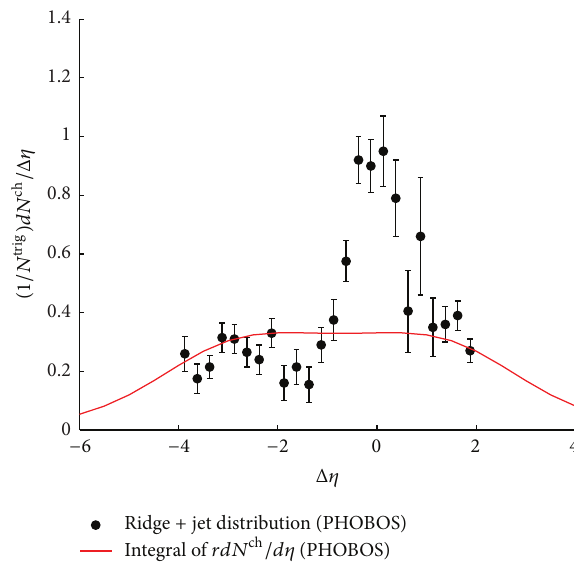
Figure 2: Two-particle correlation of charged particles. Data are from [3] that include both ridge and jet components. The line is a plot according to (3) using 𝜂 distribution from Figure 1 [12] (color